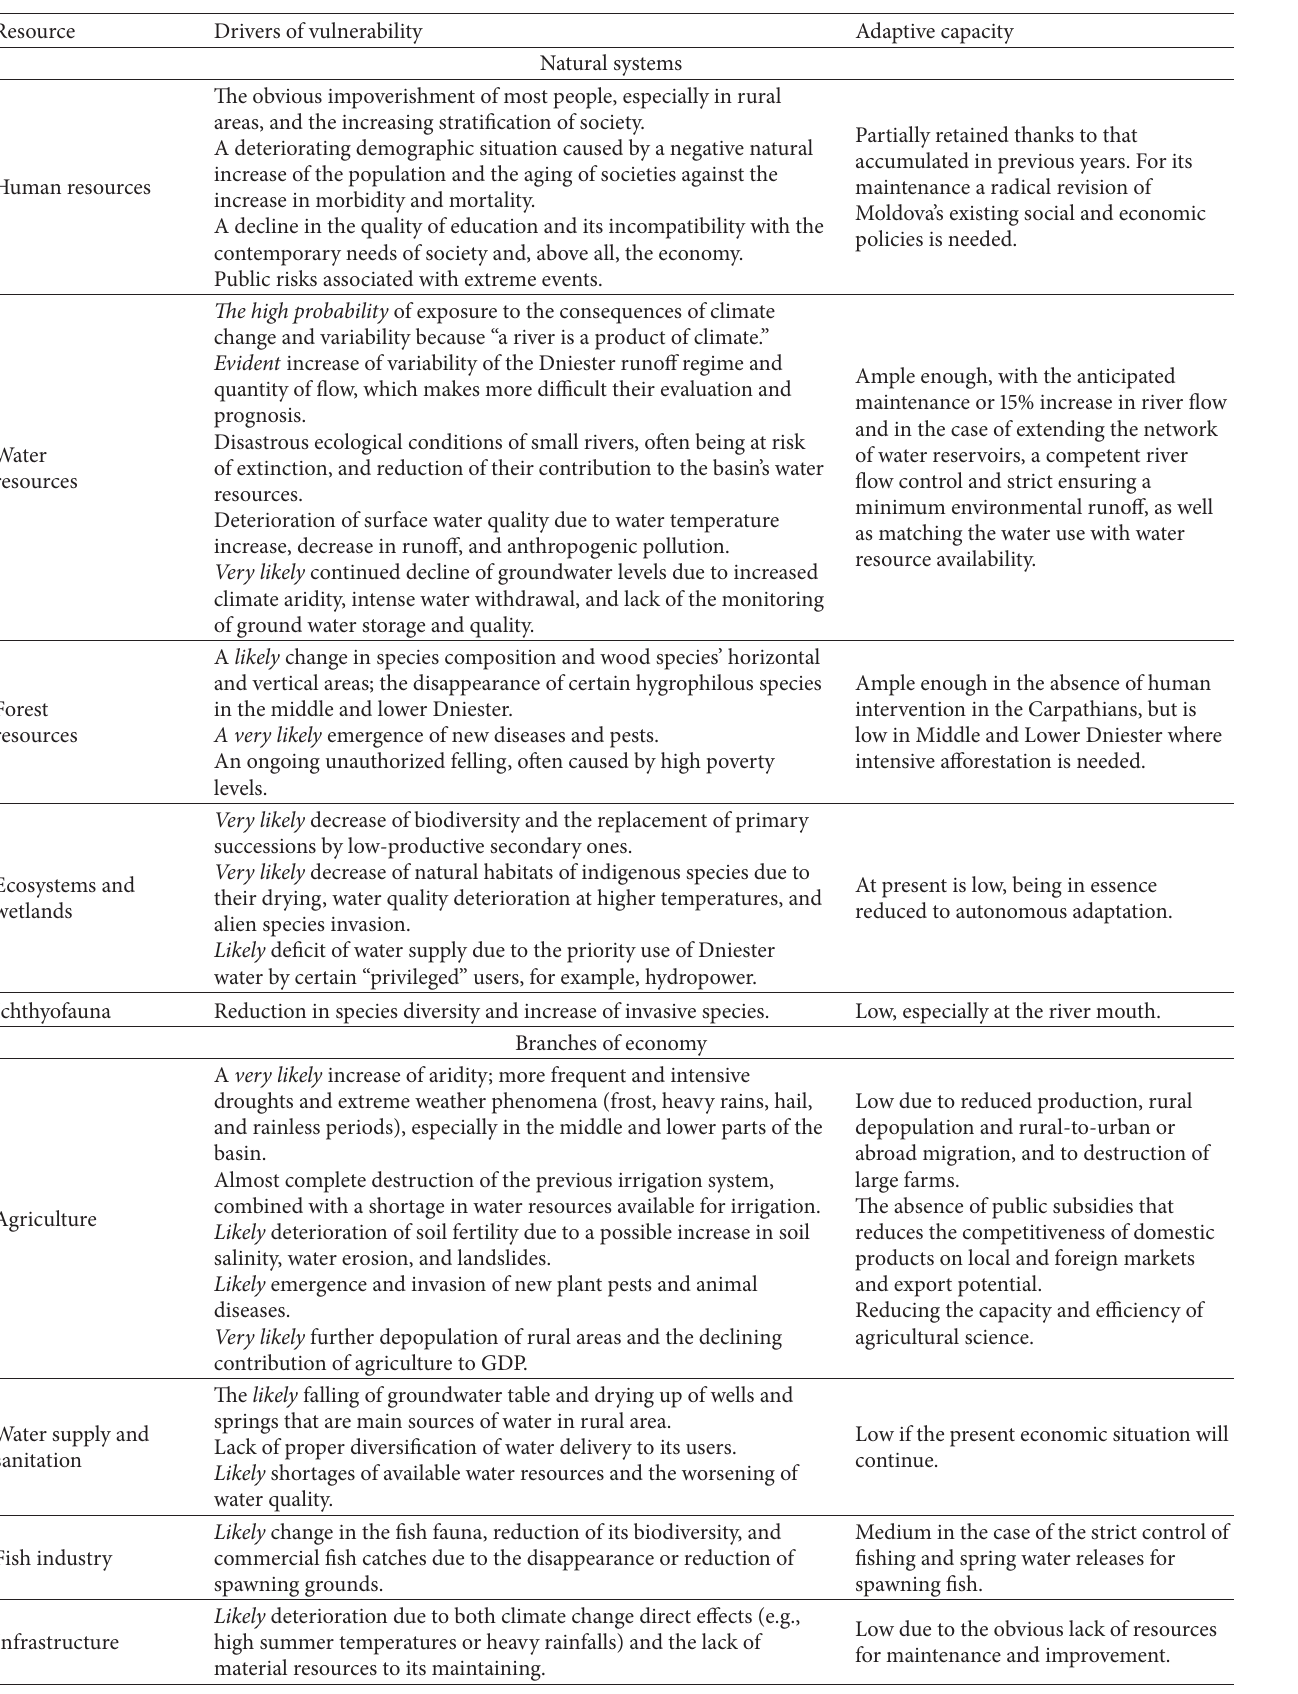
Table 7: The most vulnerable resources in the Dniester river